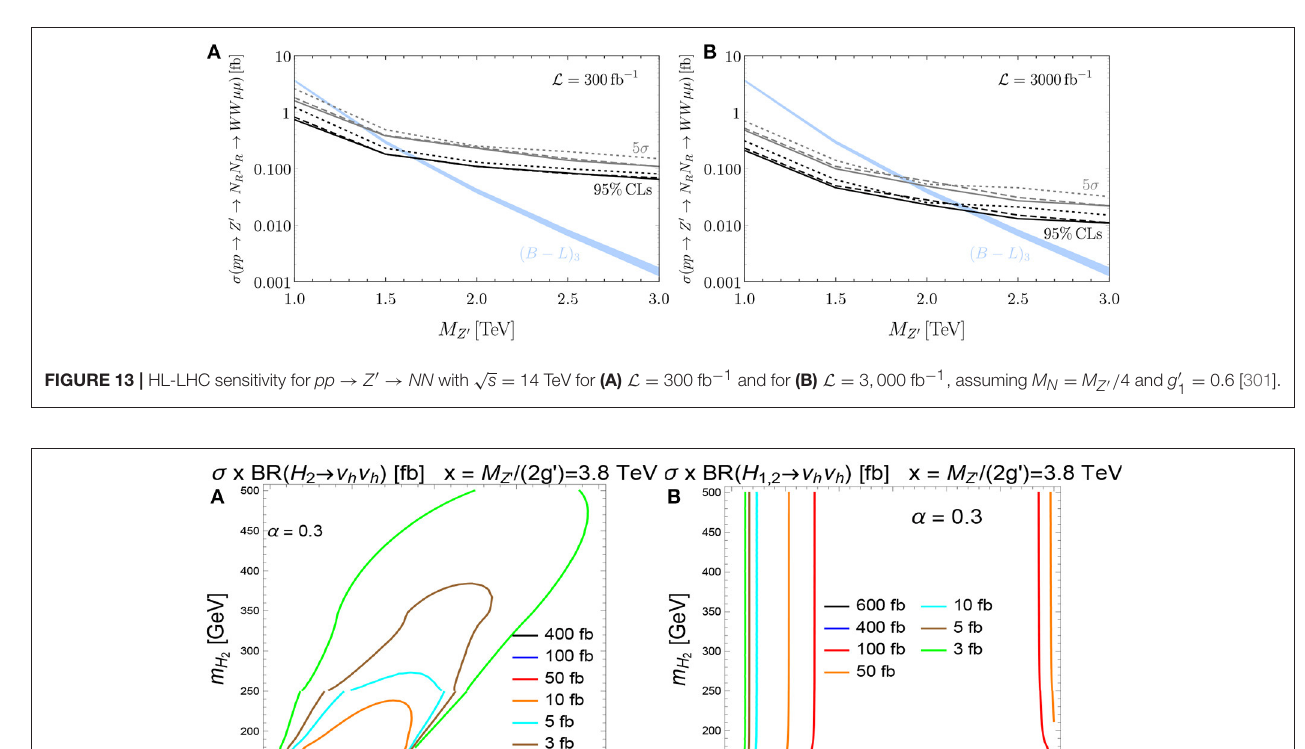
FIGURE 12 | (A) The total cross section of pp (B) The total cross section of pp